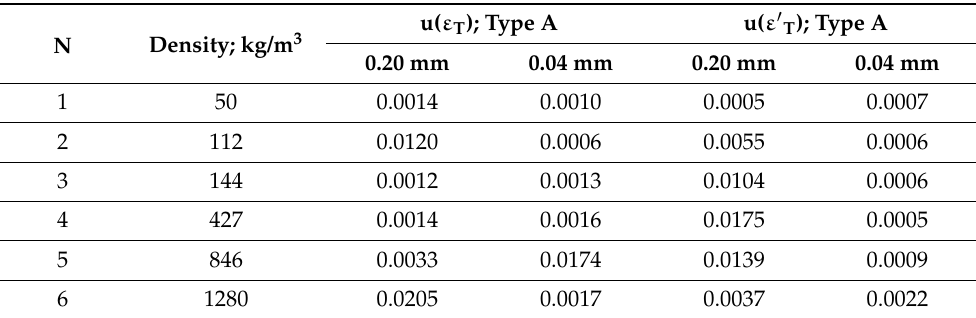
Table 7. Measurement uncertainties of the measured permittivity spectra (at f 7 , permittivity spectra as